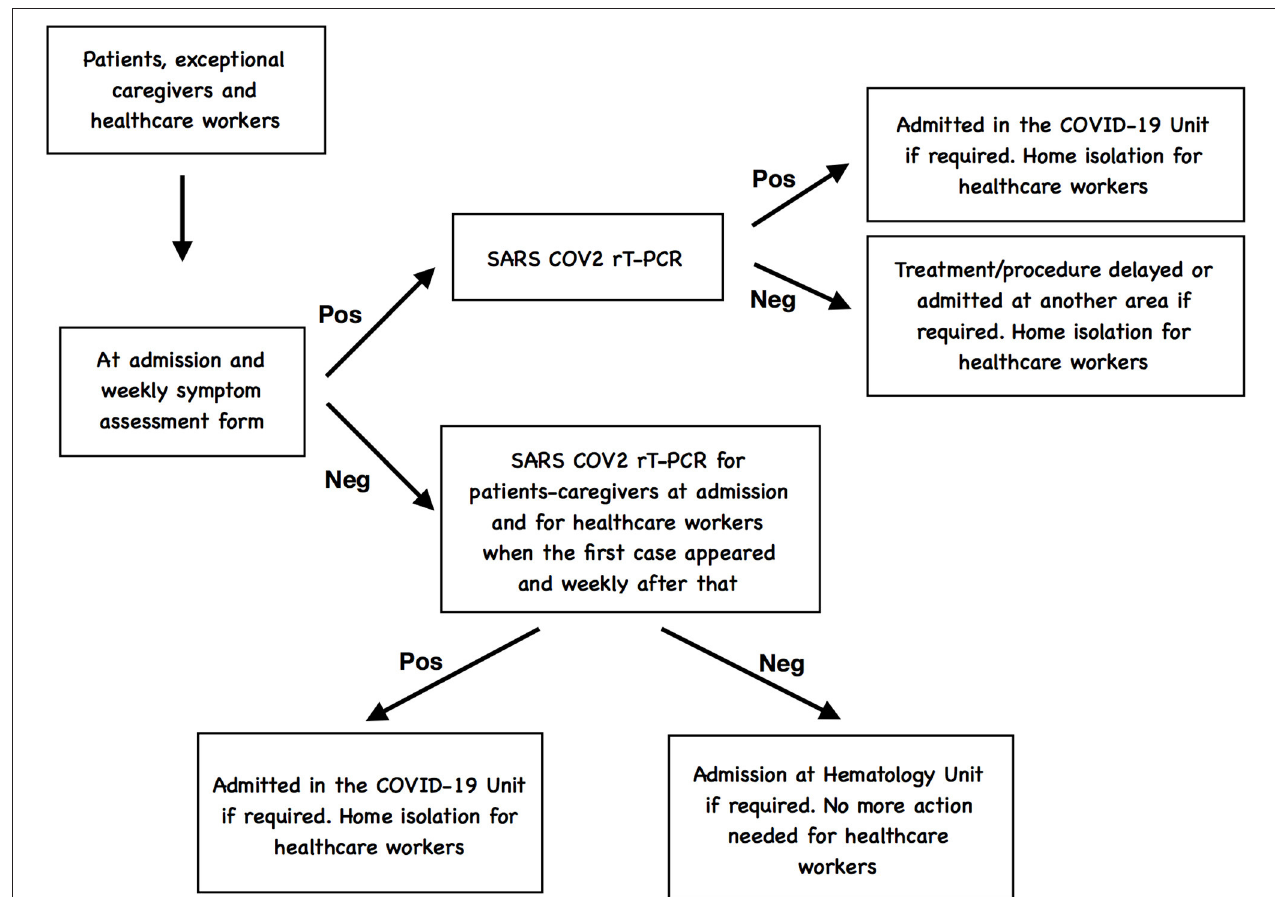
FIGURE 2 | Flowchart-type diagram to represent the COVID-19 screening.